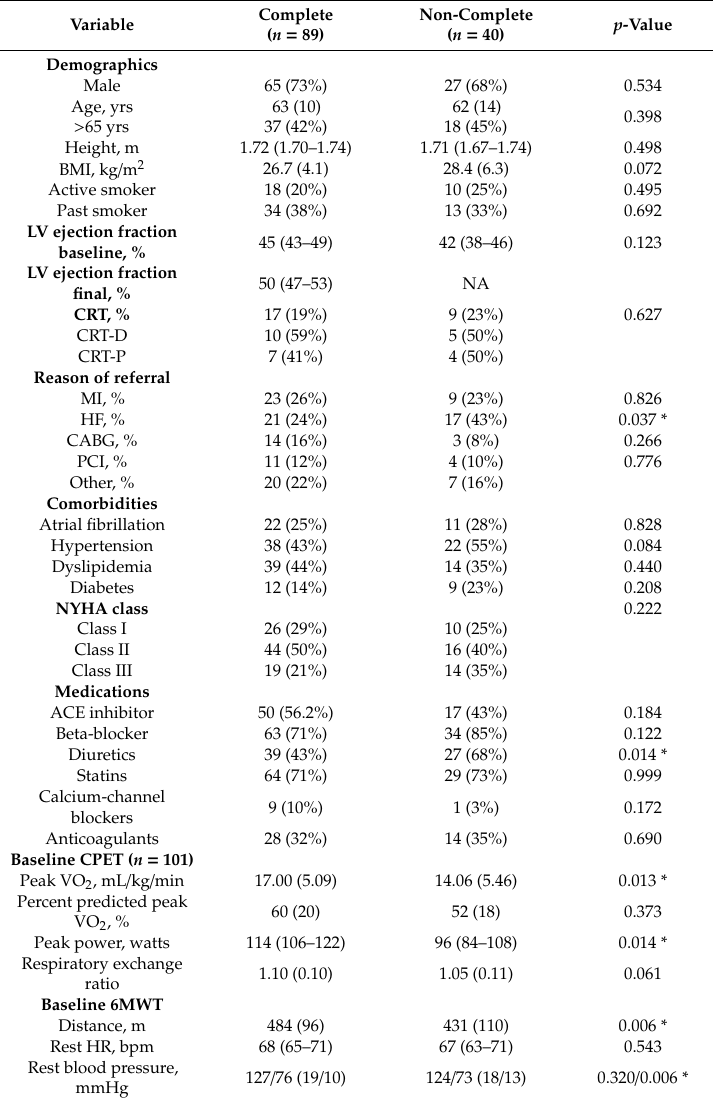
Table A2. Baseline characteristics for patients who completed all five 6MWTs (Complete) and patients who failed to finish the study protocol